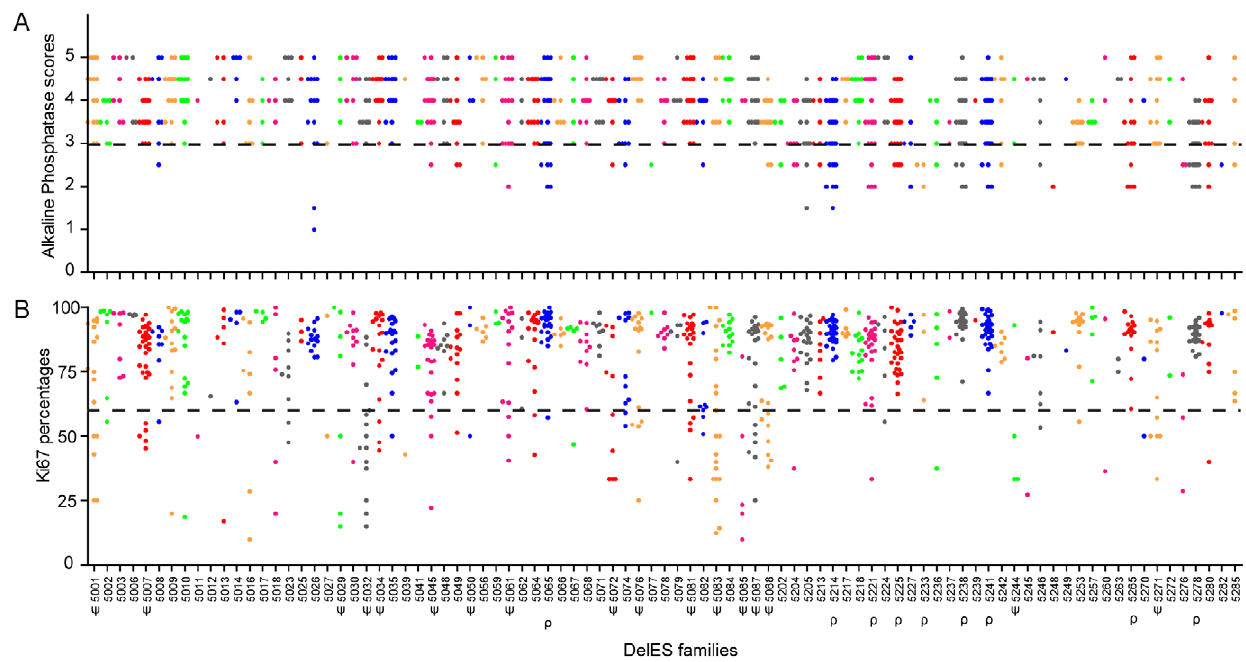
Figure 4. Quality control of DelES clones. 1080 puro S hygro 2 tertiary clones, grouped in 89 independent families, were analyzed for alkaline phosphatase (AP) staining (self-renewal/pluripotency) and expression of Ki67 (proliferation). (A) AP scores, ranging from 1 to 5 (1=weak staining; 5=strong staining), represent the mean values of one experiment performed with two independent cell densities. Approximately 9% of clones (9 families with more than two clones) demonstrated an abnormal phenotype for this assay (dashed bar represents the abnormal phenotype cutoff, arbitrarily set at 3). (B) Ki67 values are expressed as the percentage of Ki67-positive cells, gated on viable cell populations by flow cytometry. Approximately 14% of the clones (17 families with more than 2 clones) presented a proliferation defect (dashed bar represents the abnormal proliferation cutoff, stringently set at 60% Ki67-expressing cells). Families with at least 3 clones harboring an abnormal phenotype are marked by the following symbols: r or y , for AP or Ki67 category,